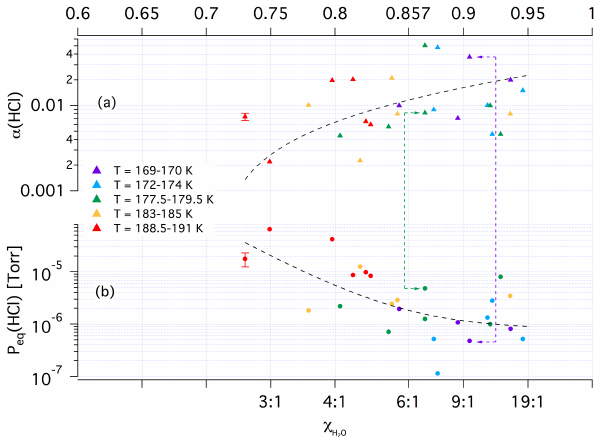
Figure 10: P eq (HCl) and α (HCl) as a function of mole fraction of H 2 O in HH film. 1252 Figure 10. P eq (HCl) and α (HCl) as a function of mole fraction of H 2 O in HH film. The bottom and top axes indicate the H 2 O:HCl ra- The bottom and top axes indicate the H 2 O:HCl ratio and the H 2 O weight percentage 1253 tio and the H 2 O weight percentage in the film, respectively. Colours in the film, respectively. Colours identify different temperature ranges and the broken 1254 identify different temperature ranges, and the broken lines just serve lines just serve to guide the eye. Coloured arrows indicate an example of pairs of data 1255 to guide the eye. Coloured arrows indicate an example of pairs of points. 1256 data 1257